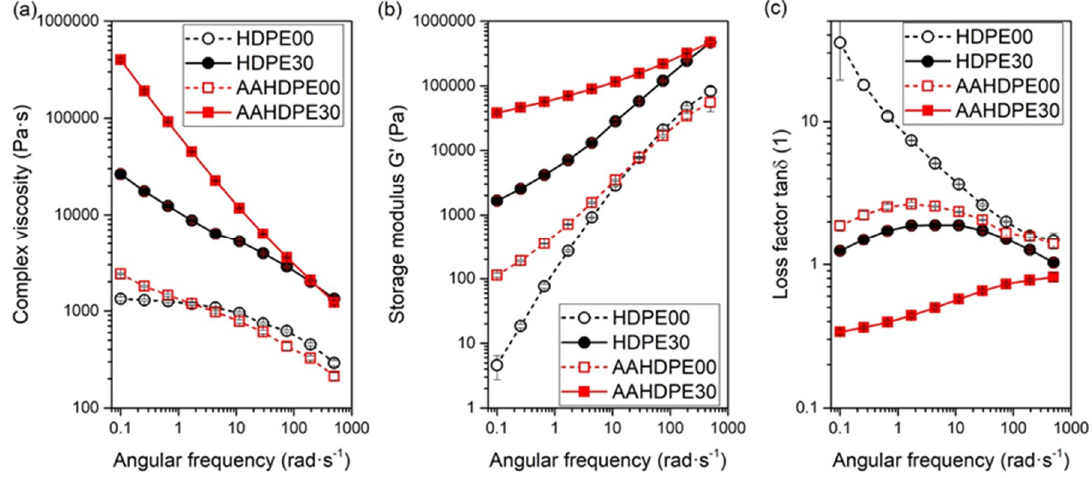
Figure 6. Viscoelastic properties as a function of angular frequency measured in parallel plate rotational rheometer at 160 °C for HDPE00, HDPE30, AAHDPE00 and AAHDPE30: ( a ) Complex viscosity, ( b ) Storage modulus and ( c ) Loss factor. Lines are included to facilitate the visualization of the results.